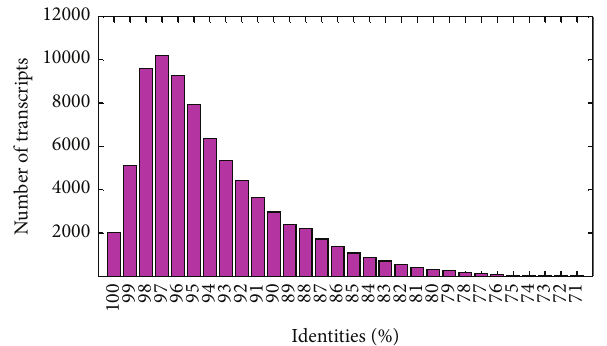
Figure 4: Sequence identity distribution of unique transcripts in Thinopyrum elongatum compared to wheat.